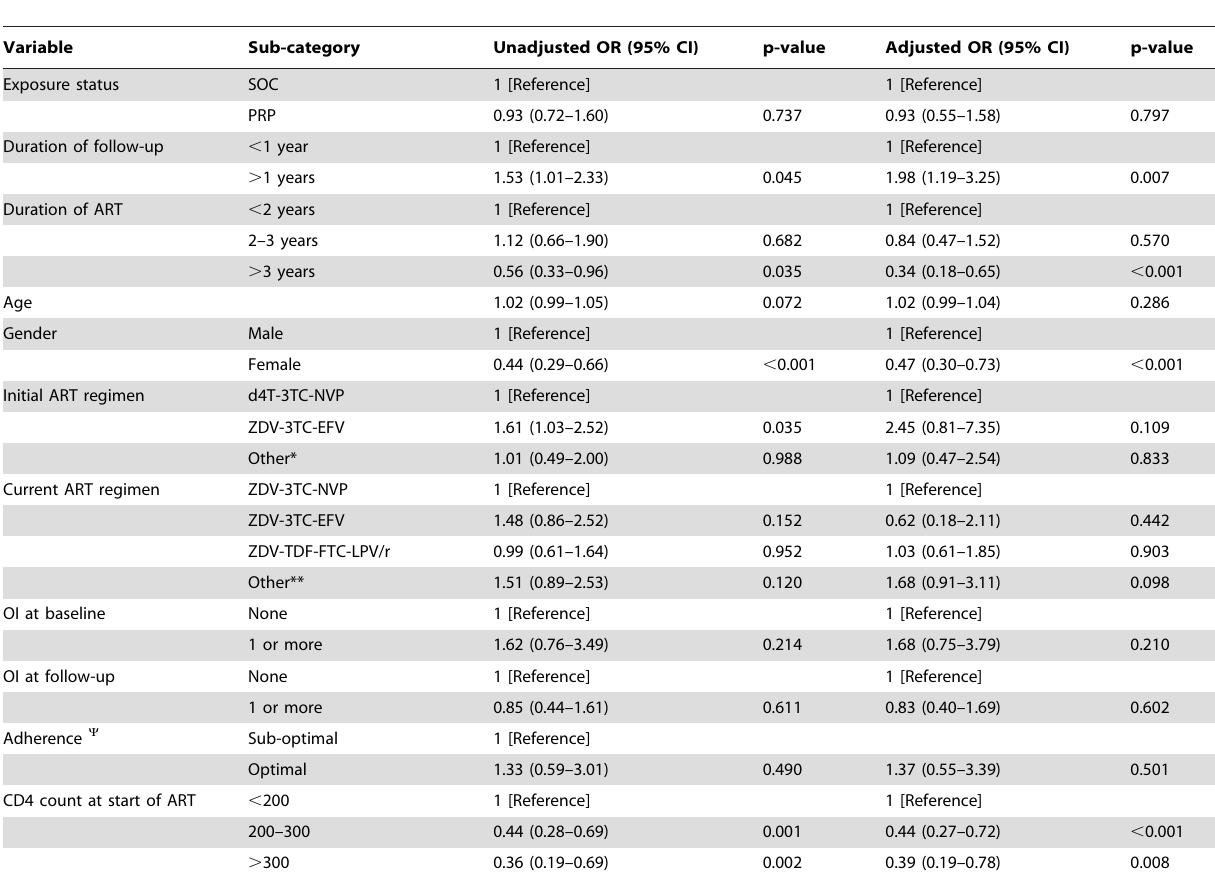
Table 2. Univaraite and multivariate logistic regression analysis of variables associated with follow-up CD4 cell count over 500 cells/ul (n= 807).